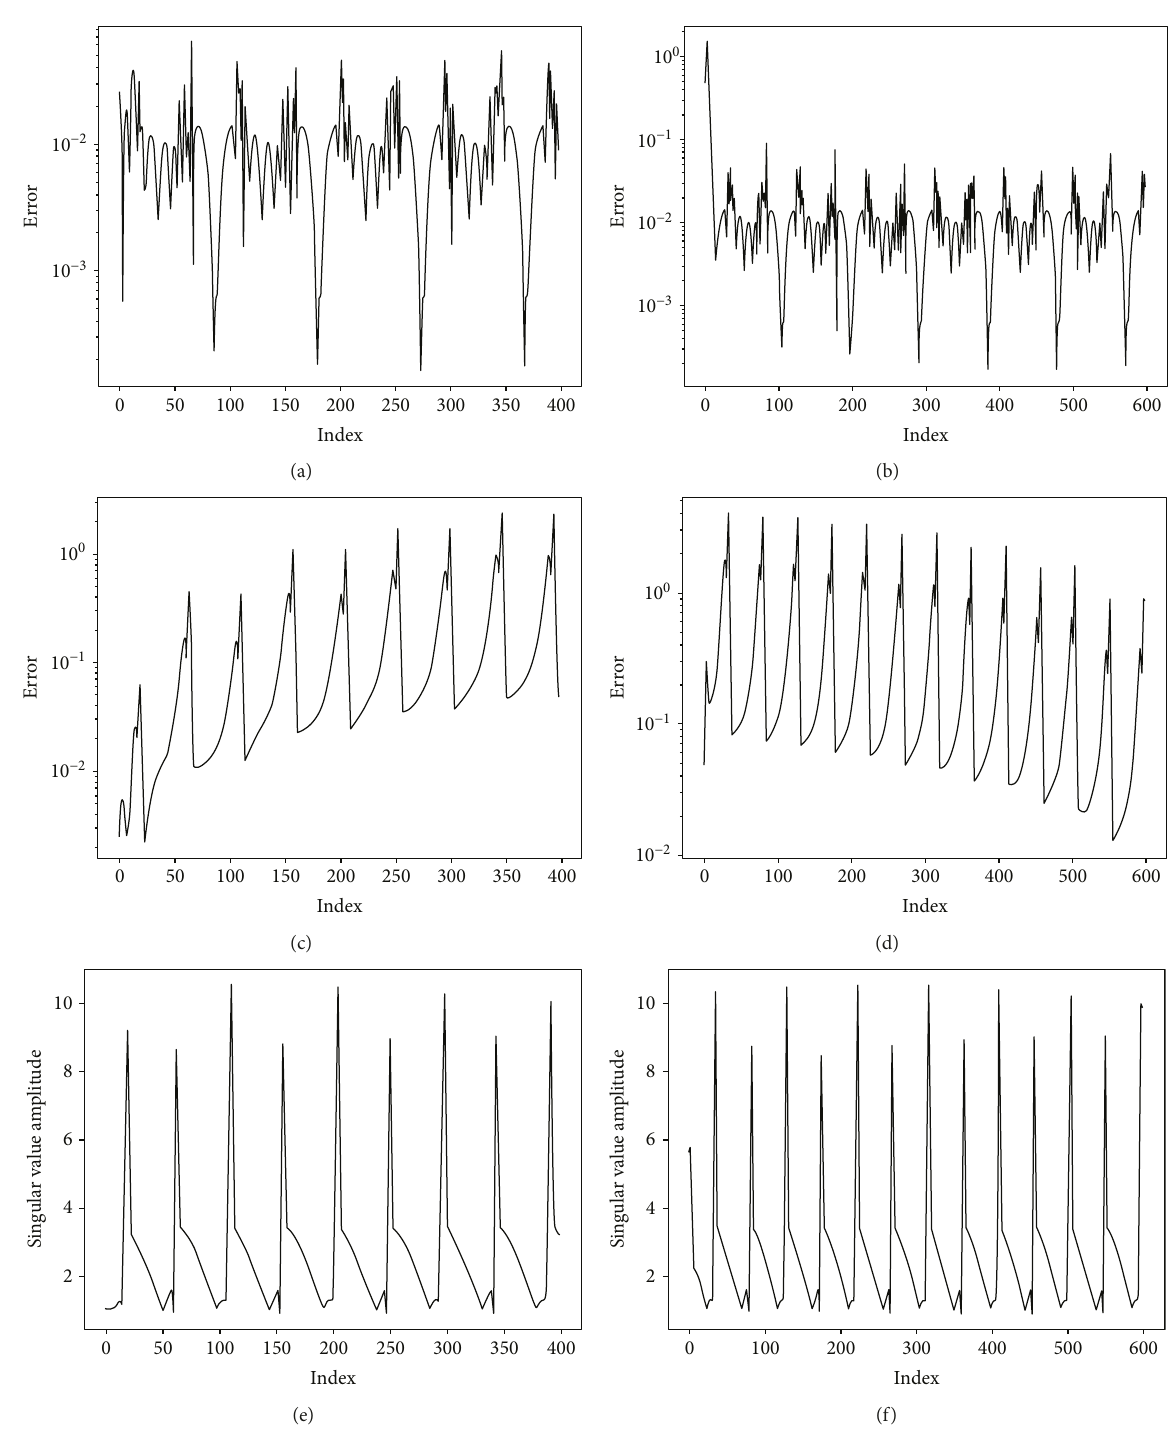
Figure 3: Variation of local error and global error: basic model on VDP case. (a, b) Local error. (c, d) Global error. (e, f) Maximal singular value of the Jacobian evaluated in a priori. (a, c, e) Training data. (b, d, f) Testing